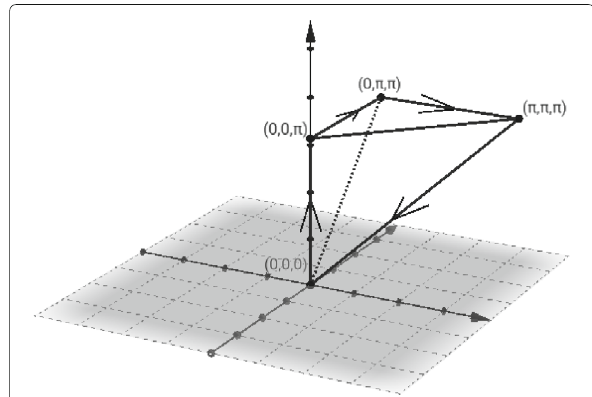
Fig. 20 This figure represents the domain 0 ≤ θ 1 ≤ θ 2 ≤ θ 3 ≤ π . The abnormal arcs corresponding to rank O = 0 are on the vertices and the edges. The arrows indicates the periodic stroke